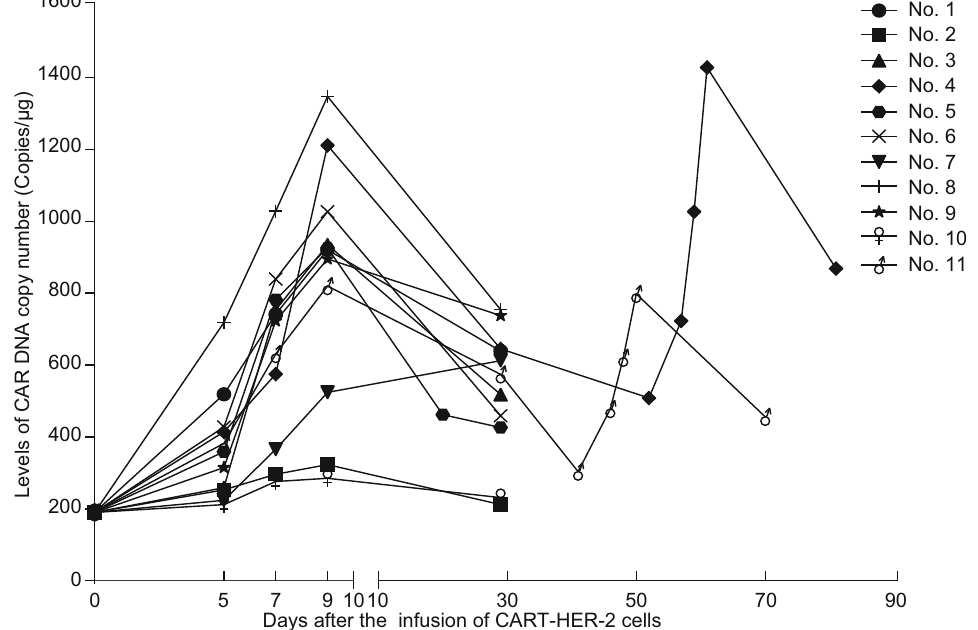
Figure 4. Change of CAR transgene copy number level in the peripheral blood following the infusion of CART-HER2 cells. Rapid elevation of CAR transgene copy numbers (>2.5-fold of the baseline value) was observed in 9/11 patients, meanwhile, 9/11 patients ’ serum CAR transgene copy numbers were still above 2-fold of the baseline level. The CAR transgene copy number after the second cycle infusion of CART-HER2 cells could reach to a similar peak of the fi rst